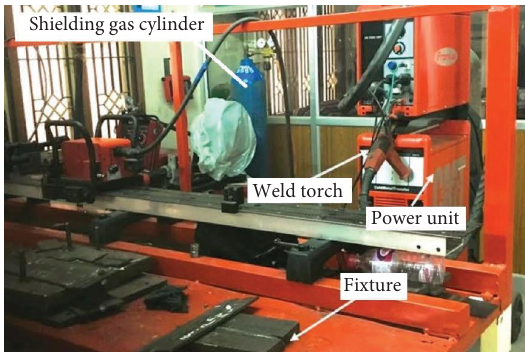
Figure 3: Photograph of CMT-welding machine setup.